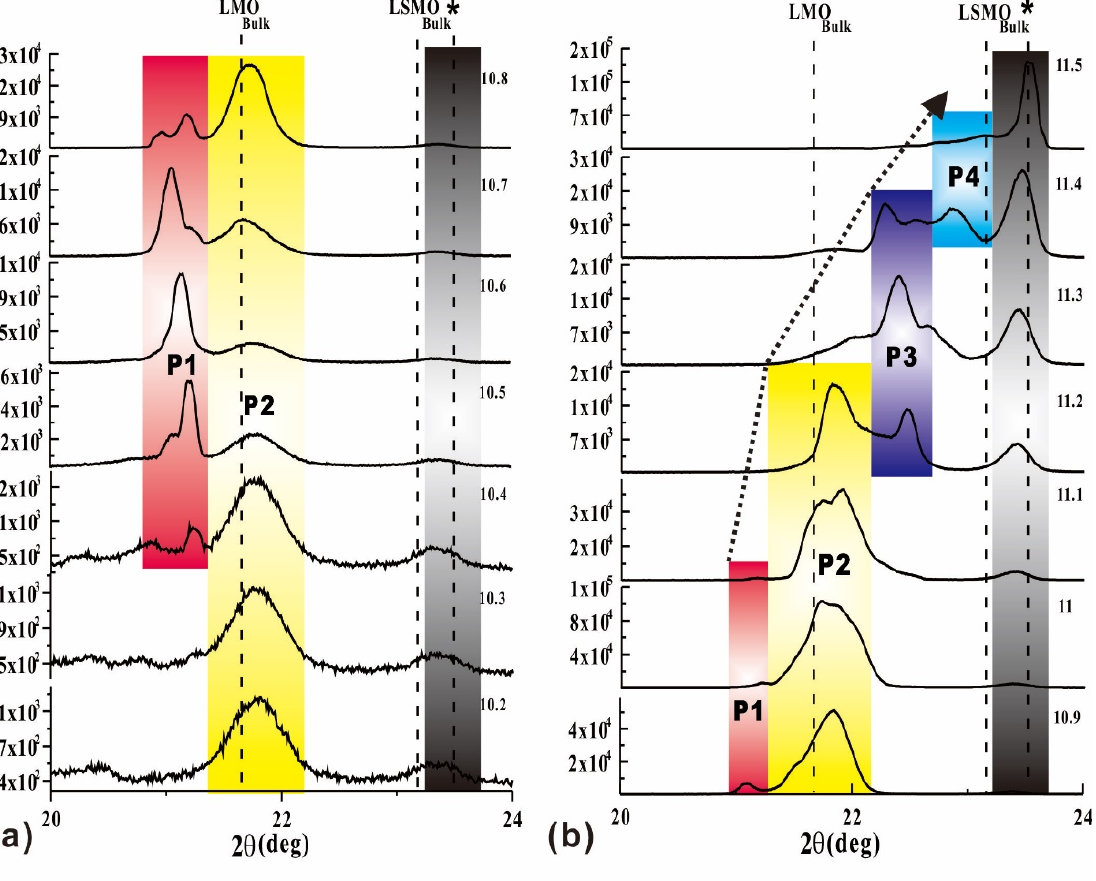
Figure 3. Low angle diffraction patterns of ECG LSMO thin film on LAO with different incident angles from ( a ) 10.2° to 10.8°; and ( b ) 10.9° to 11.5°. The four shaded areas correspond to four peaks in Figure 2. Bulk values of the lattice parameter of LMO, LSMO and substrate (marked by an asterisk) are labeled as dotted